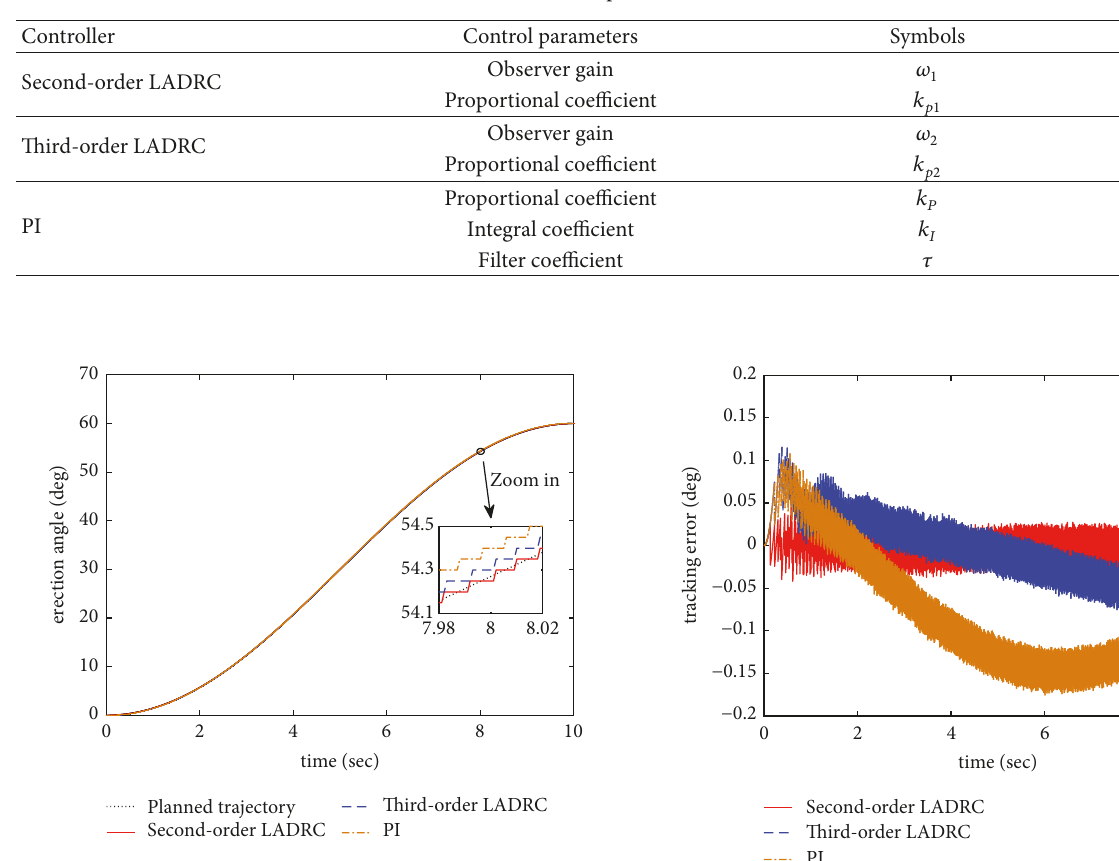
Figure 5: Tracking curves of erection angle.